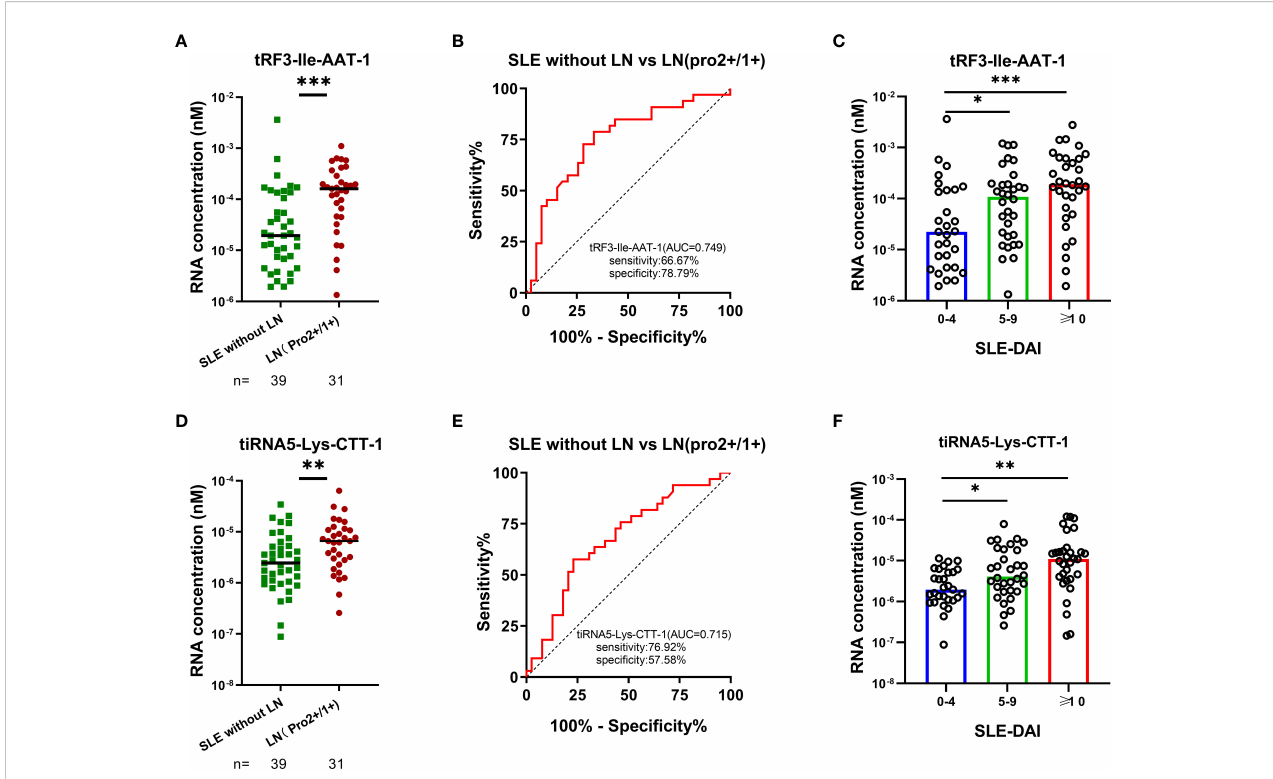
FIGURE 6 Signi fi cance of tRF3-Ile AAT-1 and tiRNA5-Lys-CTT-1 in clinical practice. (A, B) Diagnostic value of tRF3-Ile AAT-1 in LNs with proteinuria (2+)/ (1+) and SLE without LN patients. (D, E) Diagnostic value of tiRNA5-Lys-CTT-1 in LNs with proteinuria (2+)/ (1+) and SLE without LN patients. (C, F) Correlation between tRF3-Ile AAT-1, tiRNA5-Lys-CTT-1 and the activity of SLE measured by SLE-DAI 2000 (0-4, no activity; 5-9, mild activity; ≥ 10, moderate to severe